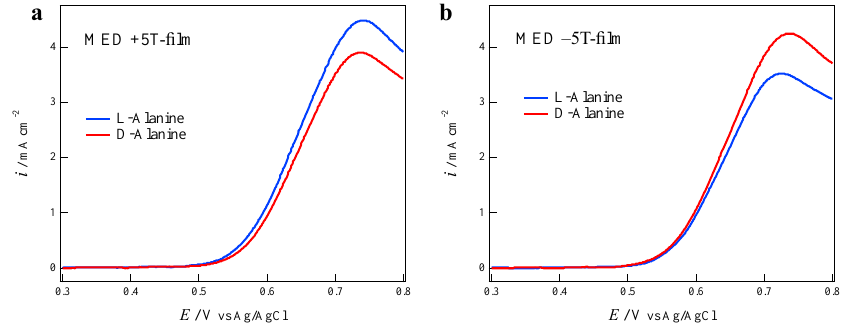
Figure 2. Voltammograms of alanine enantiomers on the MED Cu film electrodes: ( a ) on the +5T-film electrode prepared at a deposition current of 20 mA cm −2 ; ( b ) on the −5T-film electrode prepared at 17 mA cm −2 .